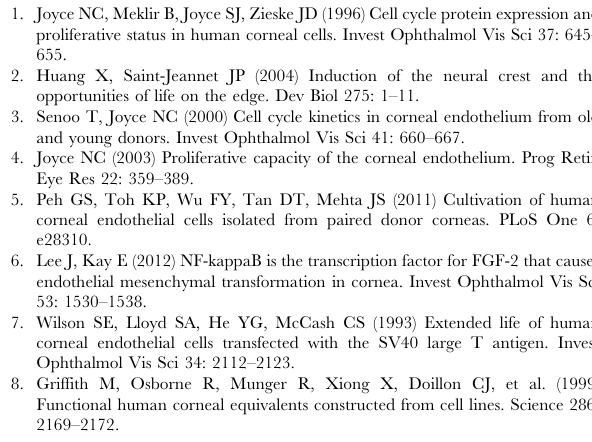
Figure S1 Existence of distinct subpopulations of cells in primary cultures from older donors. (A,B) Phase contrast micrographs of primary cells from 56-year-old donor at passage 3. (C,D) Phase contrast micrographs of primary cells from 70-year- old donor at passage 1. Note that uniform subpopulations with polygonal cells growing in monolayers (B,D) were detected among non-dividing cells displaying signs of senescence (A,C) in primary cultures of both older donors. 200x. (TIF) Figure S2 Morphology of subconfluent HCEnC-21 and HCEnC-21T cells. Phase-contrast micrographs of HCEnC-21 (A) and telomerase-transduced HCEnC-21 (HCEnC-21T; (B) cells in the subconfluent state. (TIF) Figure S3 Immunofluorescence detection of ZO-1 in later passages of HCEnC-21 and HCEnC-21T. (A) Confluent monolayers of passage-32 HCEnC-21 and (B) pas- sage-46 HCEnC-21T cells were fixed and labeled for ZO-1 (green) and nuclei (blue). (C) Representative example of the secondary antibody only controls showing no antibody binding. Note that ZO-1 in later passage cells localized to the cell-cell contacts as seen in earlier passage cells. 400x.